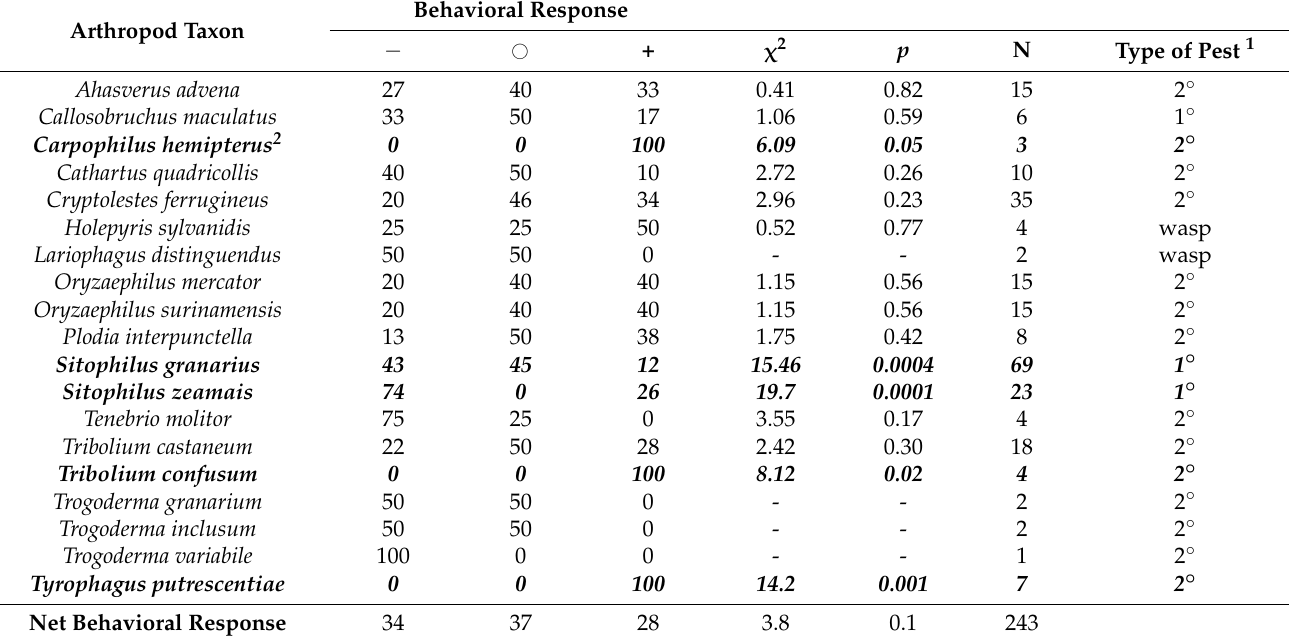
1 Abbreviations: 1 ◦ —primary pest, 2 ◦ —secondary pest. 2 Note: stored-product arthropods with consistent and significant behavioral response to MVOCS are bolded and